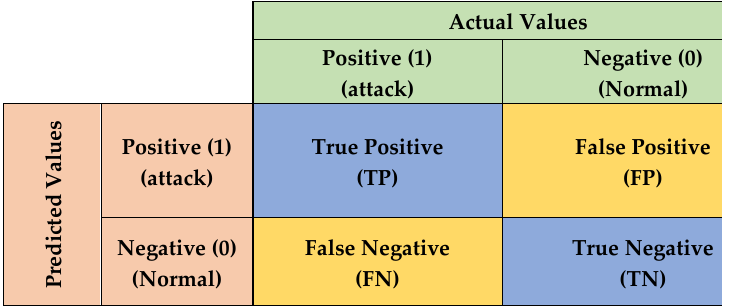
Figure 5. Confusion matrix.